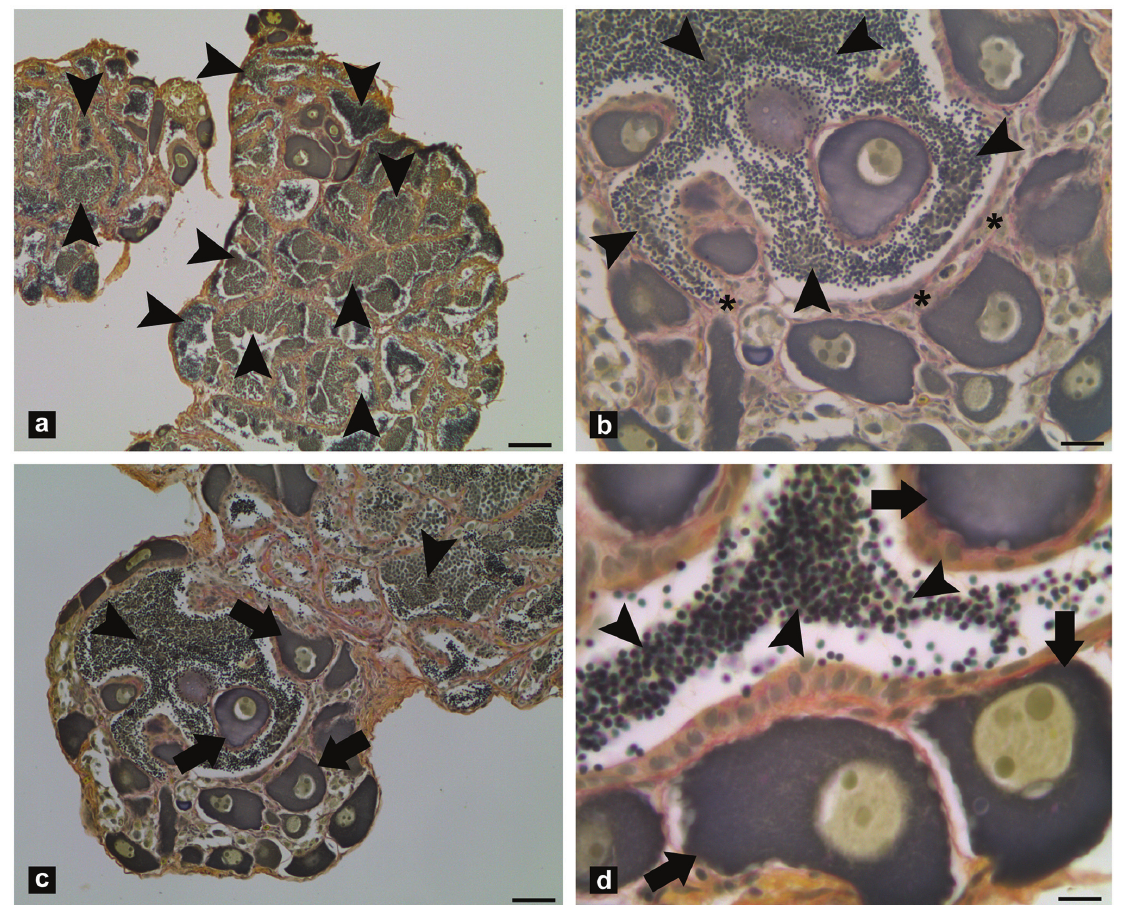
Fig. 3. Micrographs of the ovotestes of Steindachneridion parahybae juveniles in captivity showing the different germ cell types. a) unrestricted spermatogonial testes with anastomosing tubular type, composed by numerous tubules (arrowhead); b) many spermatozoa inside the tubular lumen (arrowhead), separated by interstitial tissue (asterisk); c) gonads section showing perinucleolar oocyte (arrow) close to testicular tissue (arrowhead), containing spermatozoa inside the duct and many intratubular cists; d) ovotestes showing perinucleolar oocyte (arrow) close to spermatozoa inside the duct (arrowhead). Periodic-Acid-Schiff (PAS)/Weigert’s Haematoxylin/Metanil Yellow staining. Scale bars: 74 µm (a); 19 µm (b, d); 37 µm